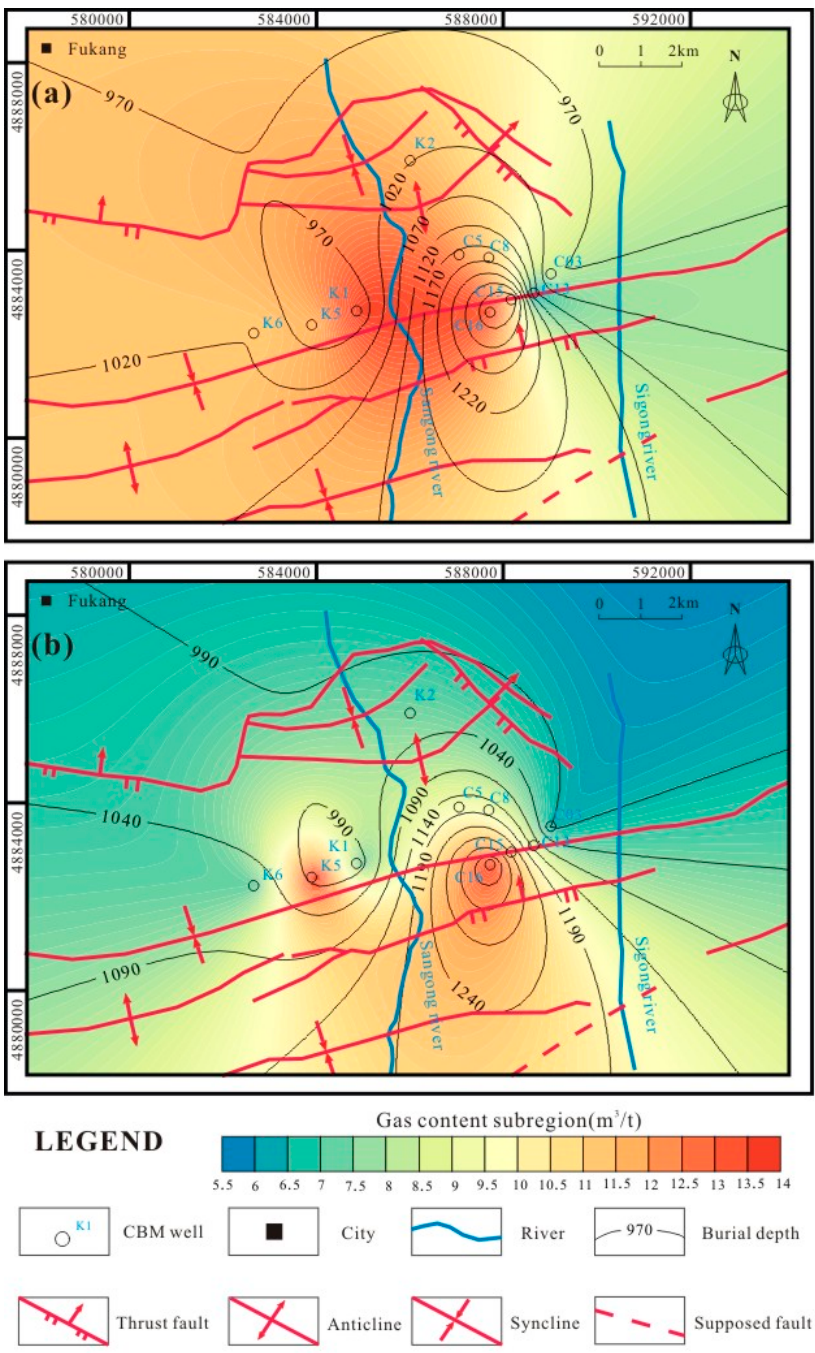
Figure 12. Relationship between gas content and burial depth of No. 45-1 ( a ) and 45-2 ( b ) coal seams in the Fukang syncline (units of contour lines: m for burial depth and m 3 /t for gas content with different color areas).